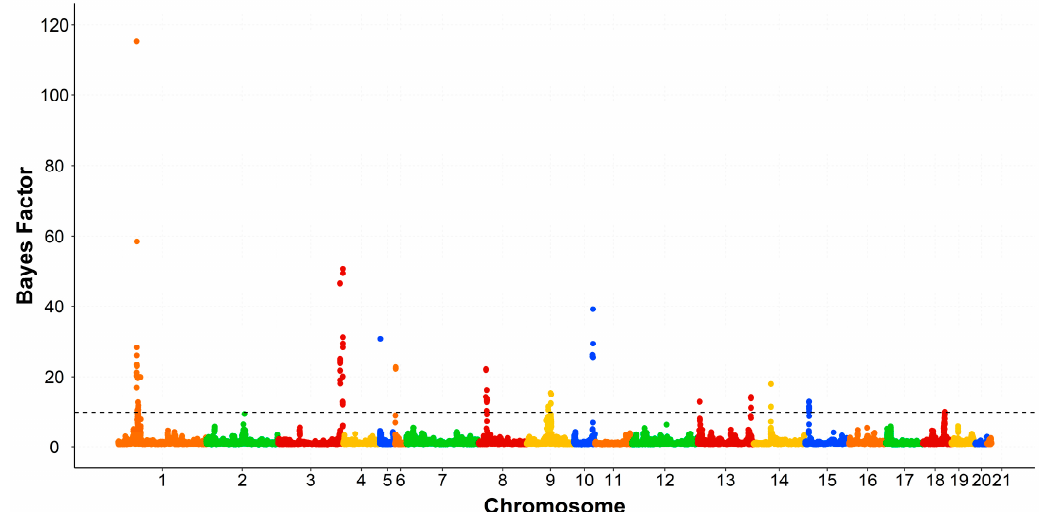
Figure 1. Manhattan plot of genome-wide association study for saturated fatty acids. The black dashed line indicates the Bayes factor threshold of 10. Each dot represents a Single Nucleotide Polymorphism (SNP). X-axis: chromosomes. Y-axis: Bayes factor.